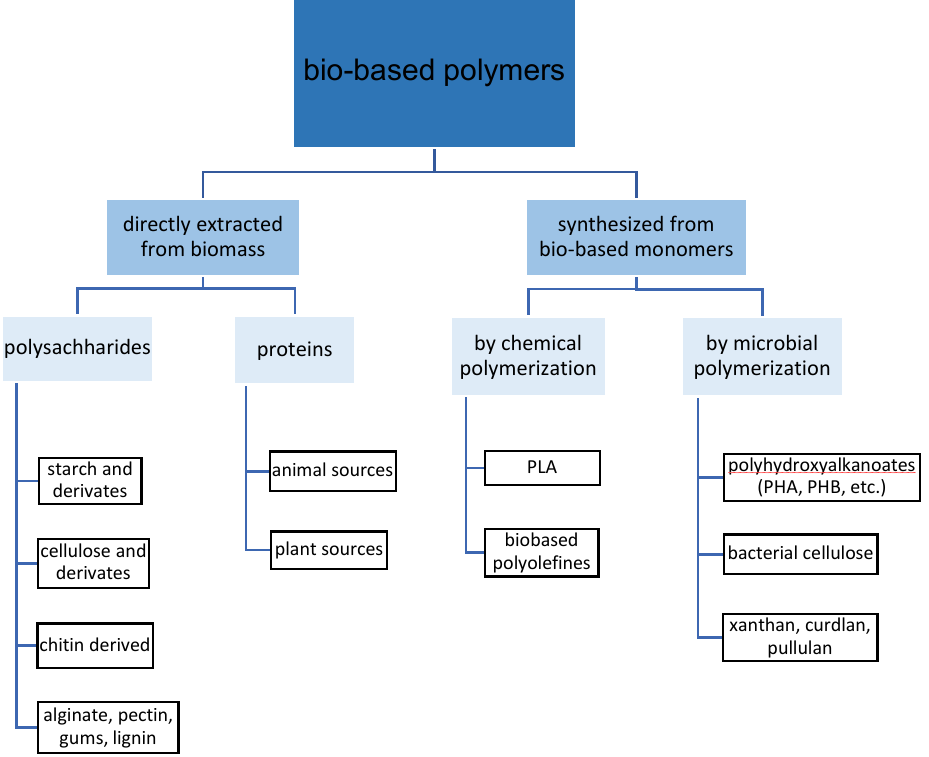
Figure 1. Bio-based polymers, their origin, and method of production.